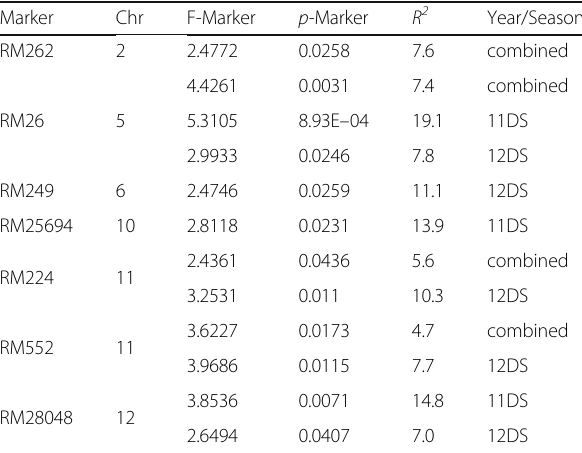
teins, tetra- and pentatricopeptide proteins, no apical meristem proteins (NAM), heat shock proteins (HSPs), cytochrome P450 family, ethylene response factors (AP2/ ERFs), auxin response factors (ARFs), brassinosteroids, CaMK, GDSL-like lipases, membrane proteins, hydro- lases, kinases, peroxidases, peptidase and dismutase family proteins, zinc finger proteins (ZFPs), leucine zipper motifs (ZIP) and myeloblastosis (MYB) transcription factors. The role of these genes/gene families in abiotic stress tolerance is well known. Enrichment analysis of the list of genes Table 3 Markers significantly associated with grain yield under drought stress Marker